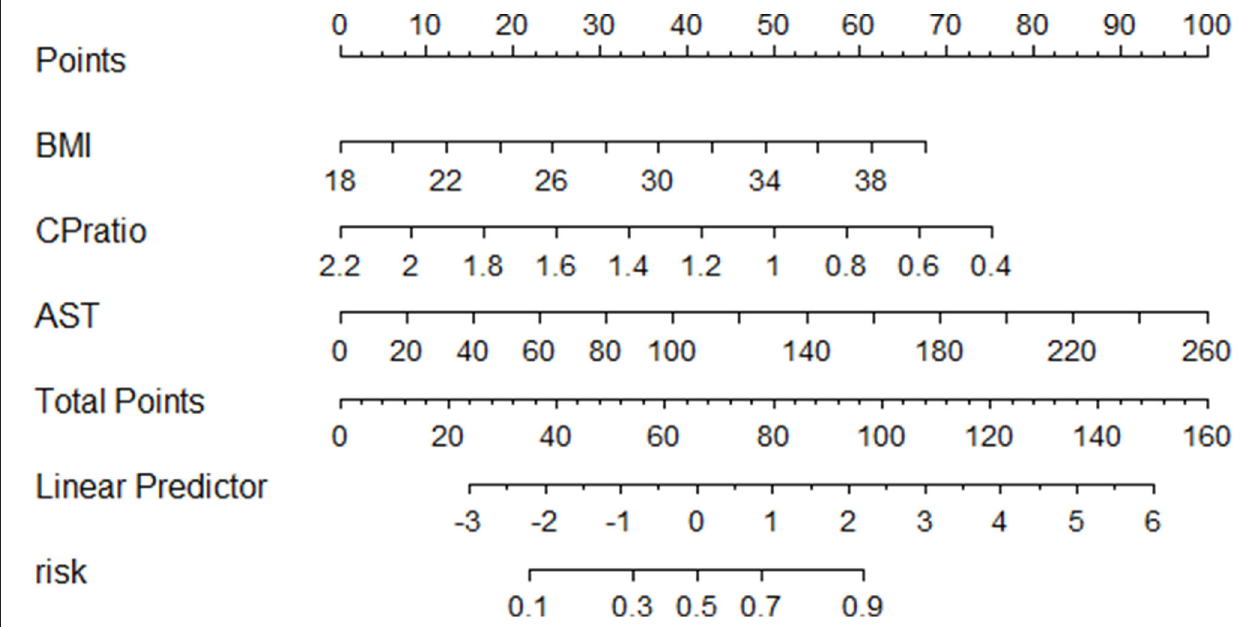
FIGURE 3 | The nomogram of the CP model for discriminating NASH. Abbreviations: AST, aspartate transferase; BMI, body mass index; CP,